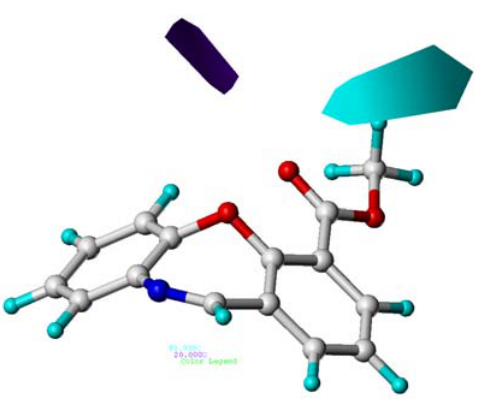
Figure 8. Contour maps of CoMSIA hydrogen bond donor region in combination with compound 10 . Hydrogen bond donor contour map. The cyan and purple (80% and 20% contributions) contours indicate favorable and unfavorable hydrogen bond donor groups. Compound 10 is depicted in ball and stick representation, coloured by atom type (white C, blue N, red O, cyan